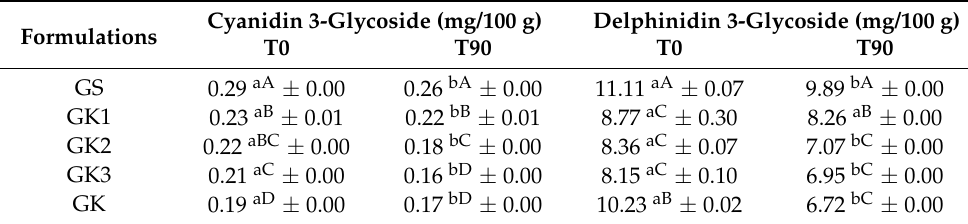
Table 5. Quantification of anthocyanins cyanidin 3-glycoside and delphinidin 3-glycoside in ice cream after 0 and 90 days of